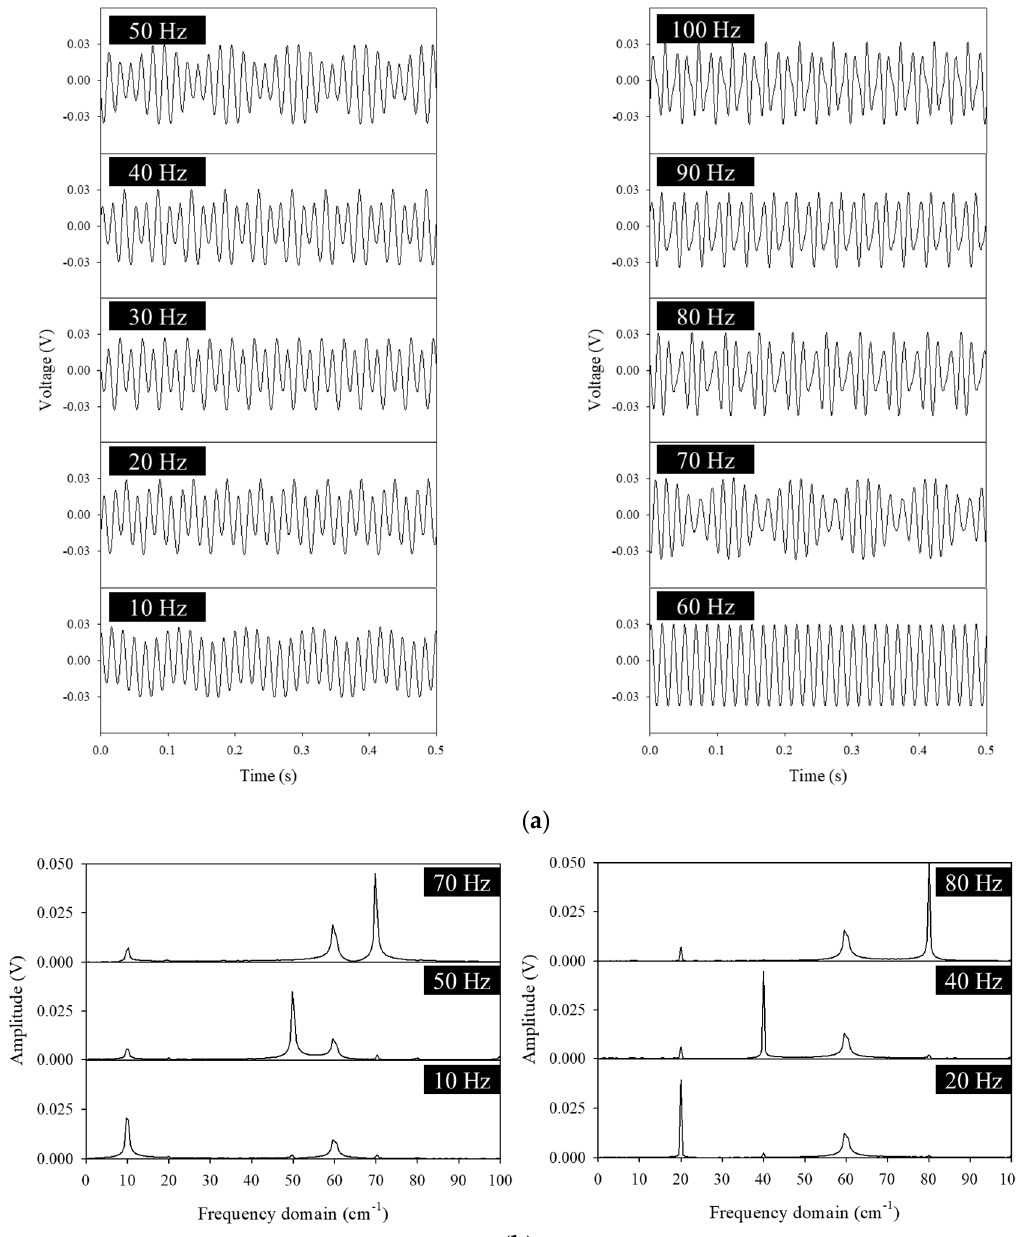
Figure 4. ( a ) Acoustic output voltages of the PVDF webs according to frequencies. ( b ) Fast Fourier transform (FFT) according to 10, 50, and 70 Hz and to 20, 40, and 80 Hz.